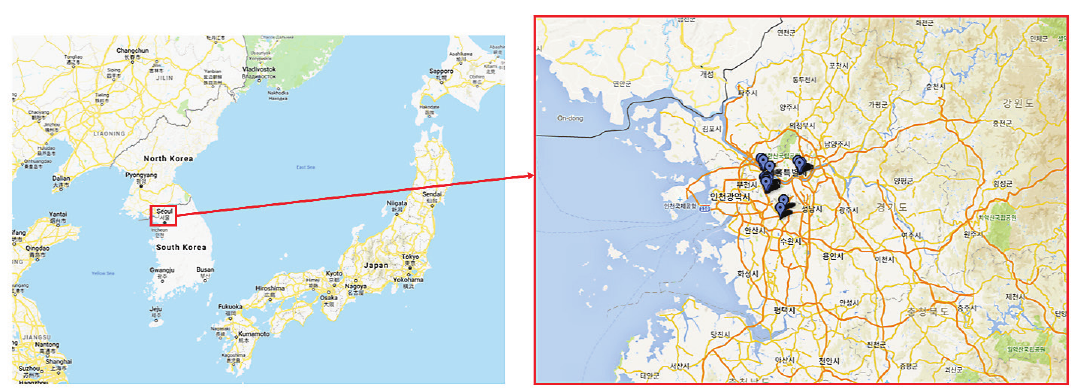
Figure 3. Study area (source: Google Map Service and Google Fusion Table,